Question: How would you classify this visualization?
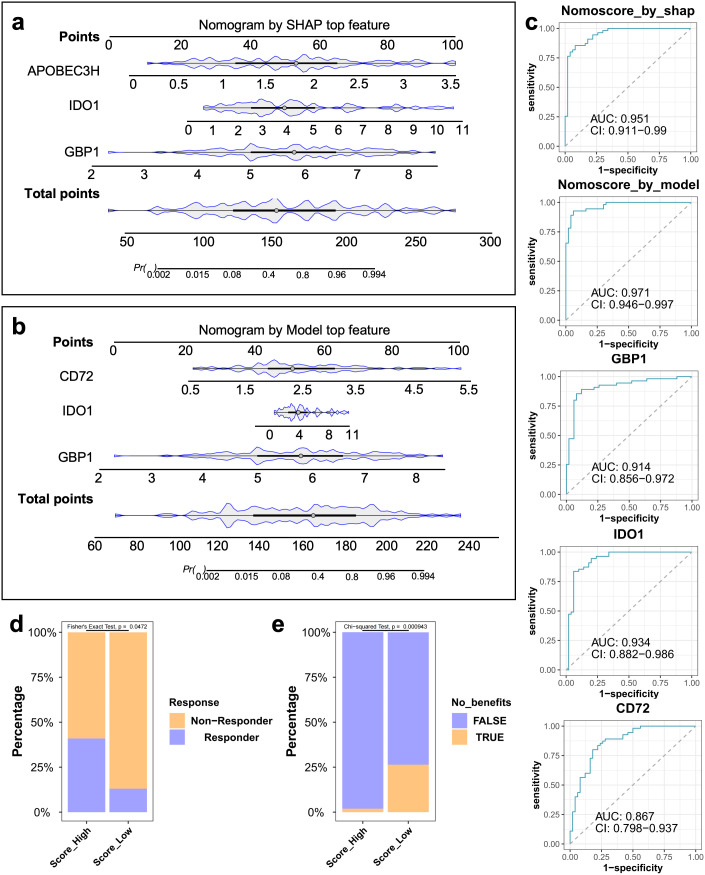
Answer: line